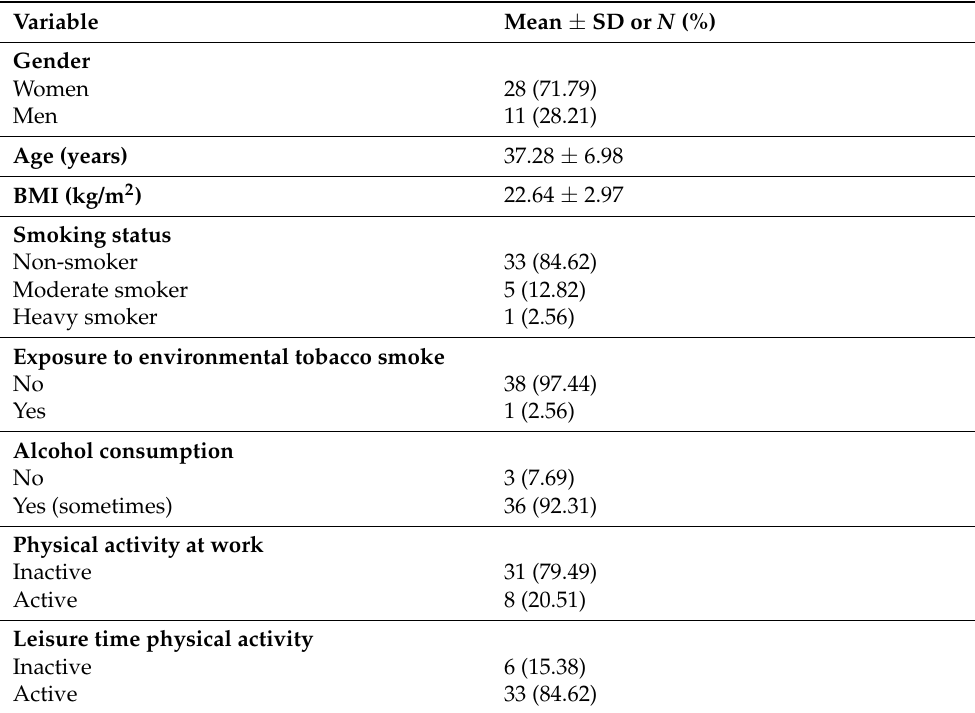
Table 1. Sociodemographic and lifestyle characteristics of the study